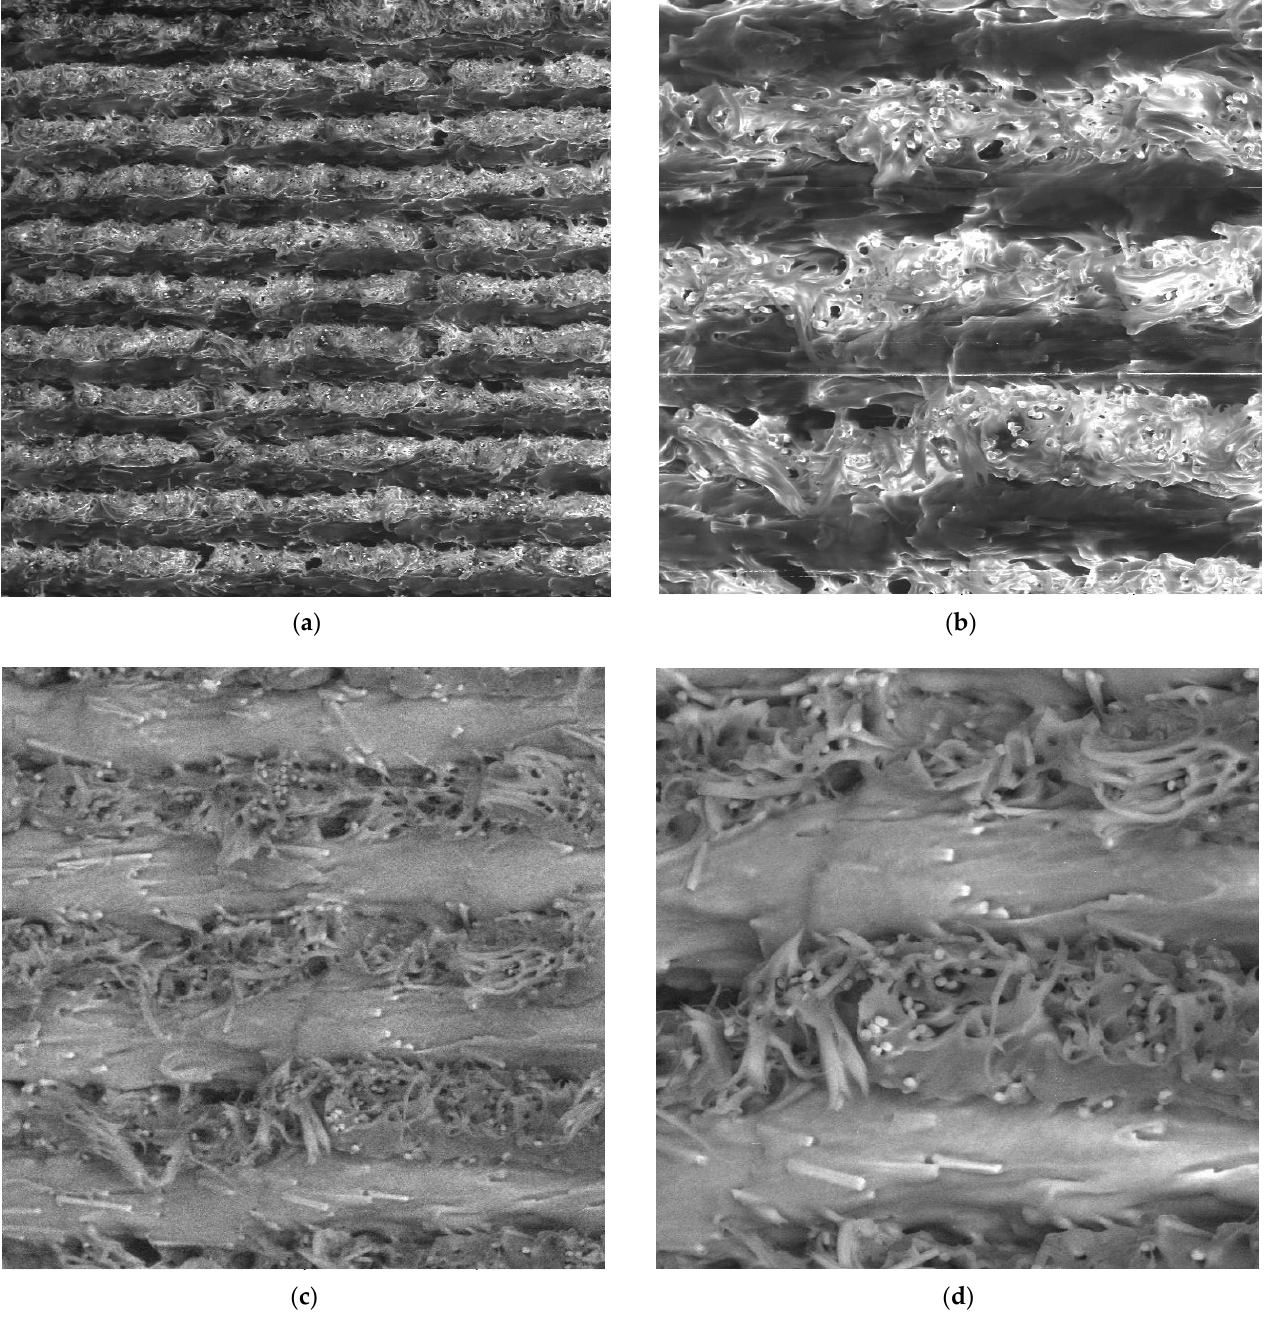
Figure 14 . SEM images of fractured specimen alpha: ( a ) 100× magnification, detector LVSD; ( b ) Figure 14. SEM images of fractured specimen alpha: ( a ) 100 × magnification, detector LVSD; ( b ) 300 × 300× magnification, detector LVSD; ( c ) 300× magnification, detector BSE; ( d ) 500× magnification, magnification, detector LVSD; ( c ) 300 × magnification, detector BSE; ( d ) 500 × magnification, detector detector BSE.